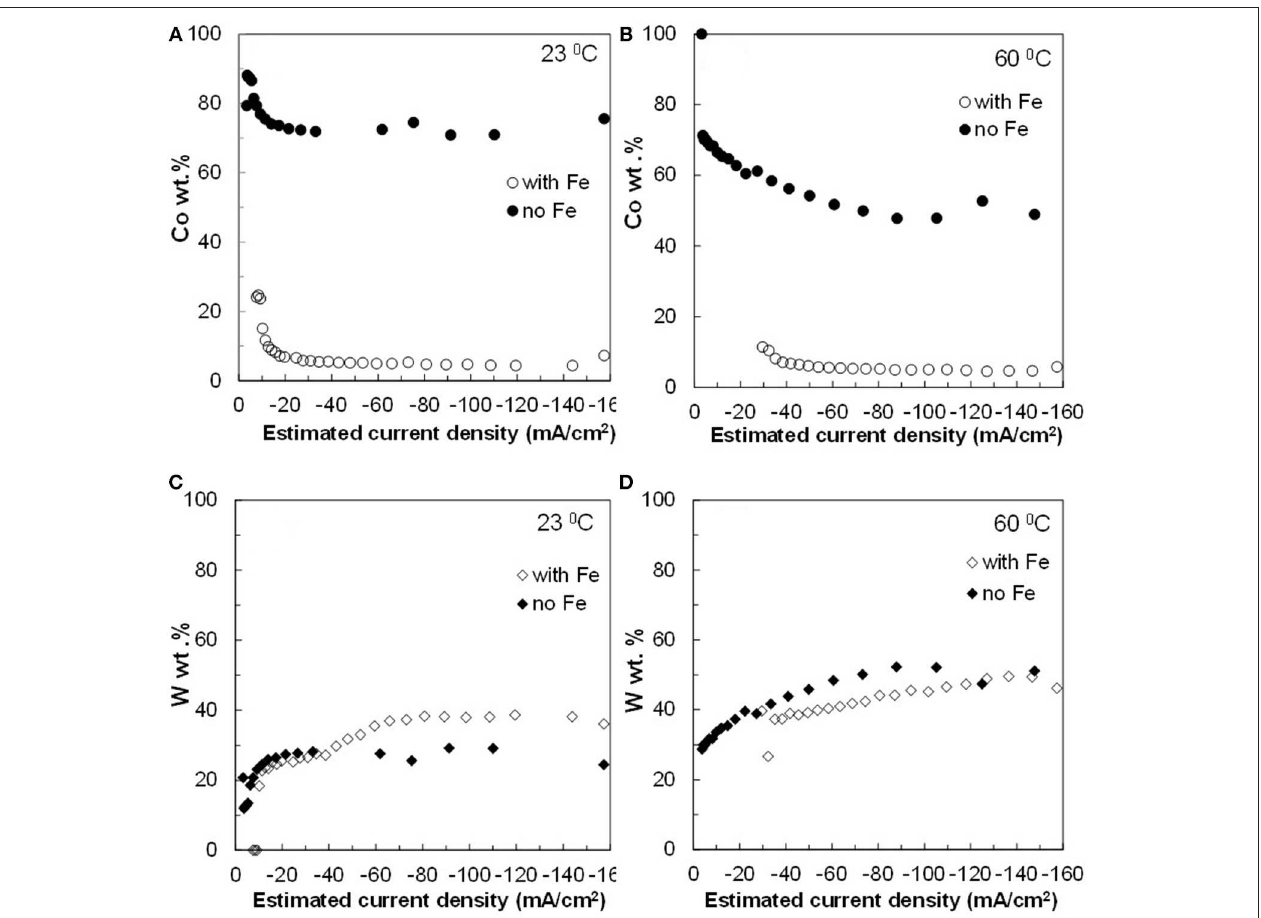
FIGURE 3 | Concentration of (A,B) Co and (C,D) W in Co–W and Fe–Co–W alloy films at two different temperatures 23 and 60 ◦ C, and at an electrode rotation rate of 600 rpm.